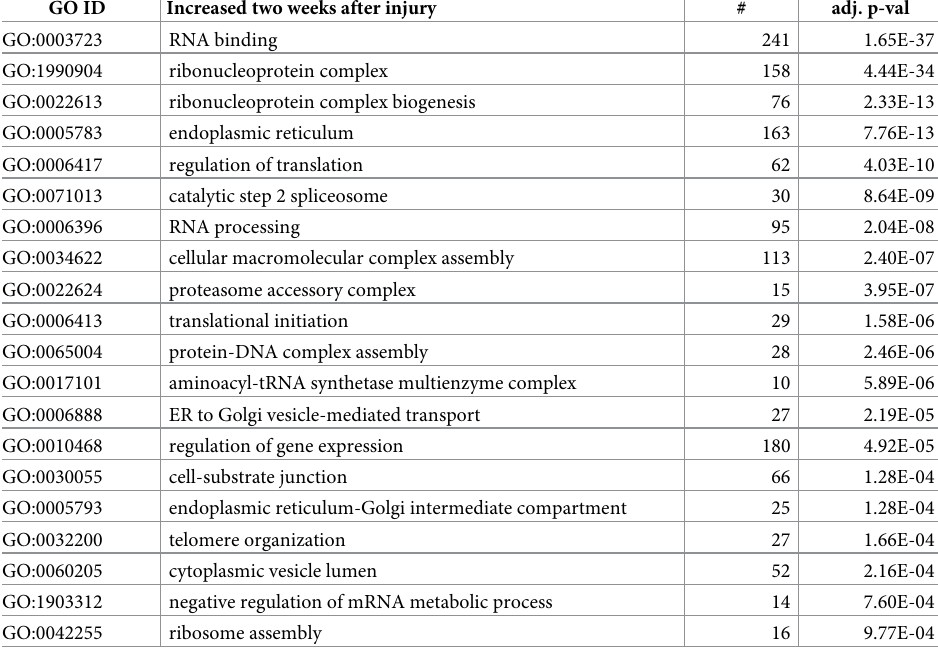
Table 3. The top significantly upregulated GO Pathways after nerve injury, the # of proteins in each pathway that were found to be significant, and their overrepresentation adjusted